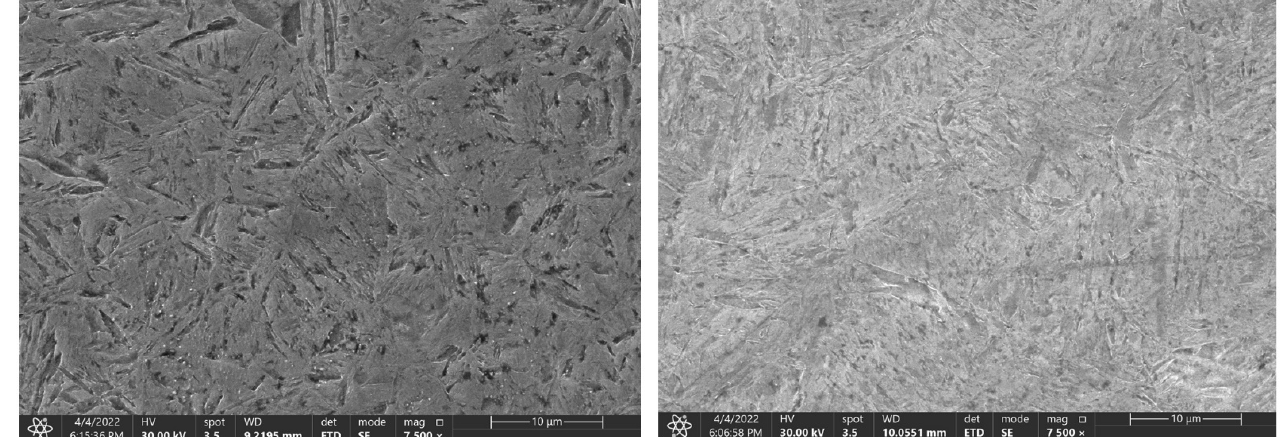
Figure 9. Change in the microstructure of the C45 steel, with a heating time of 140 s and 3600 s. At the same time, after reaching a heating time of 300 s, the first occurrence of mi- crocracks was observed for the 80CrV5 steel, and by 3600 s, the occurrence of microcracks was already observed over the whole analysed area of the sample (Figure 10, right). In terms of the subsequent accumulation of microstructural defects and crack propagation, the cyclic multi-axial loading of the component is the most dangerous [27].